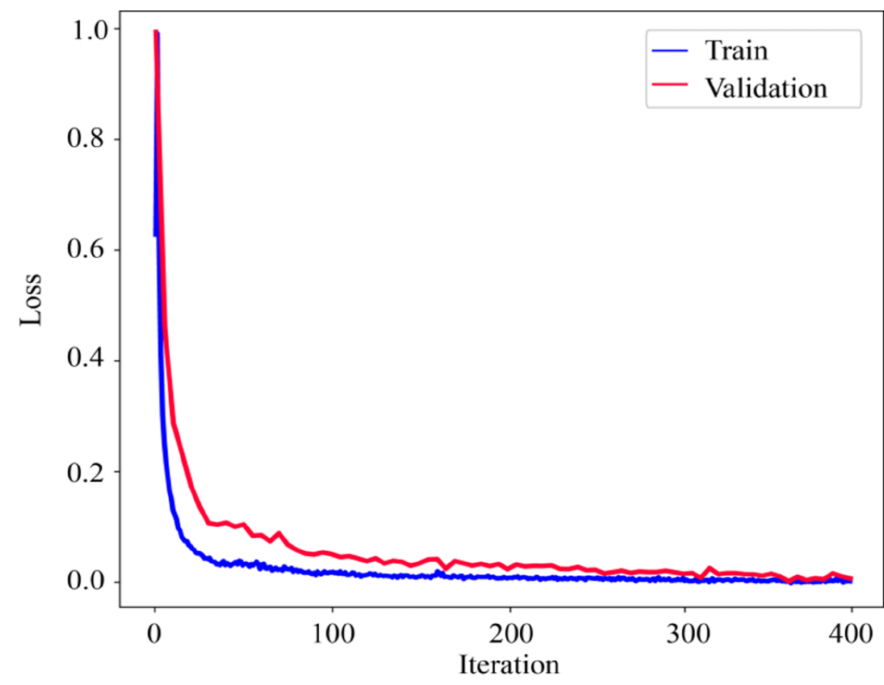
Figure 17. The loss function for training the network model using the training data sets in the field